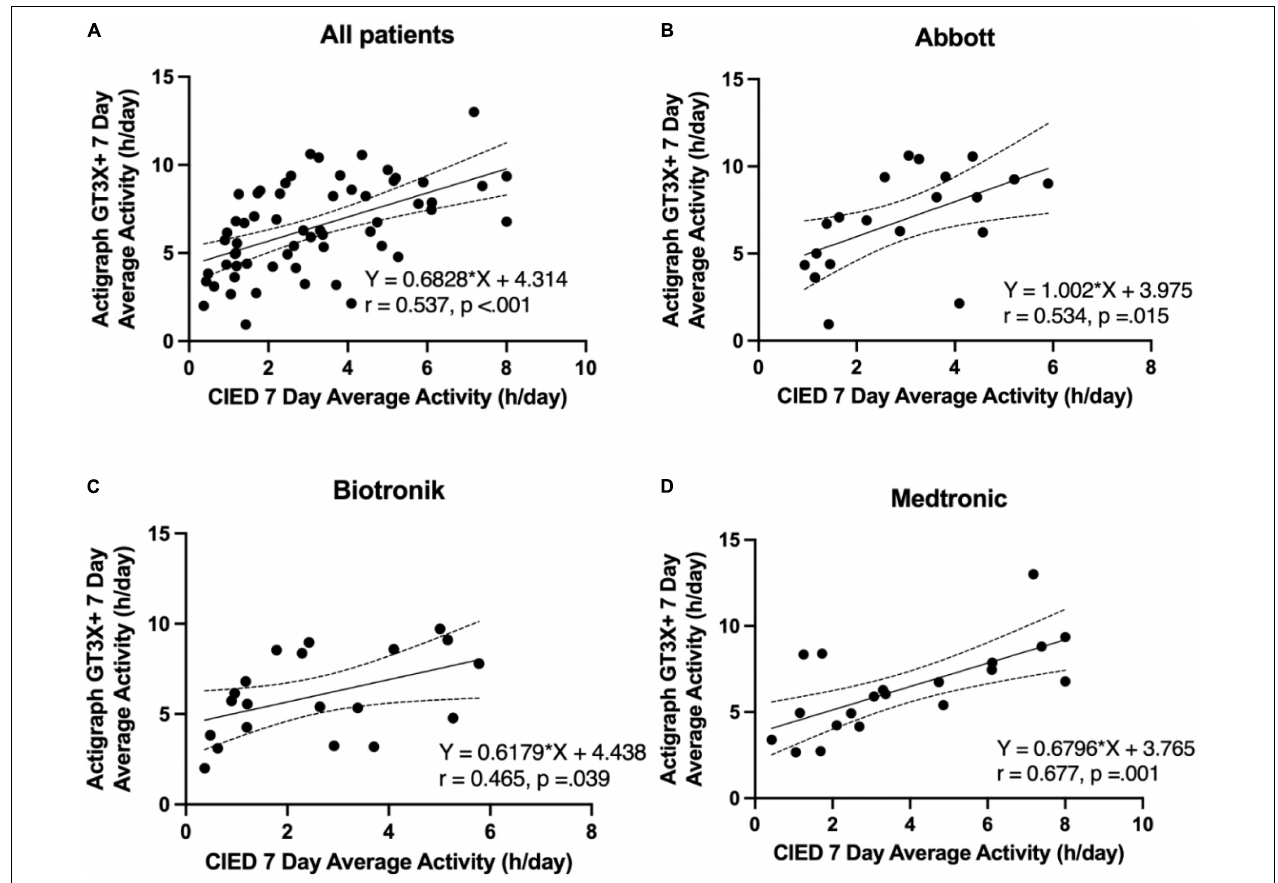
FIGURE 2 | Correlation between the 7-day average physical activity (hours per day) of the pacemakers and ActiGraph GT3X+. (A) All patients, (B) Abbott, (C) Biotronik, (D) Medtronic.